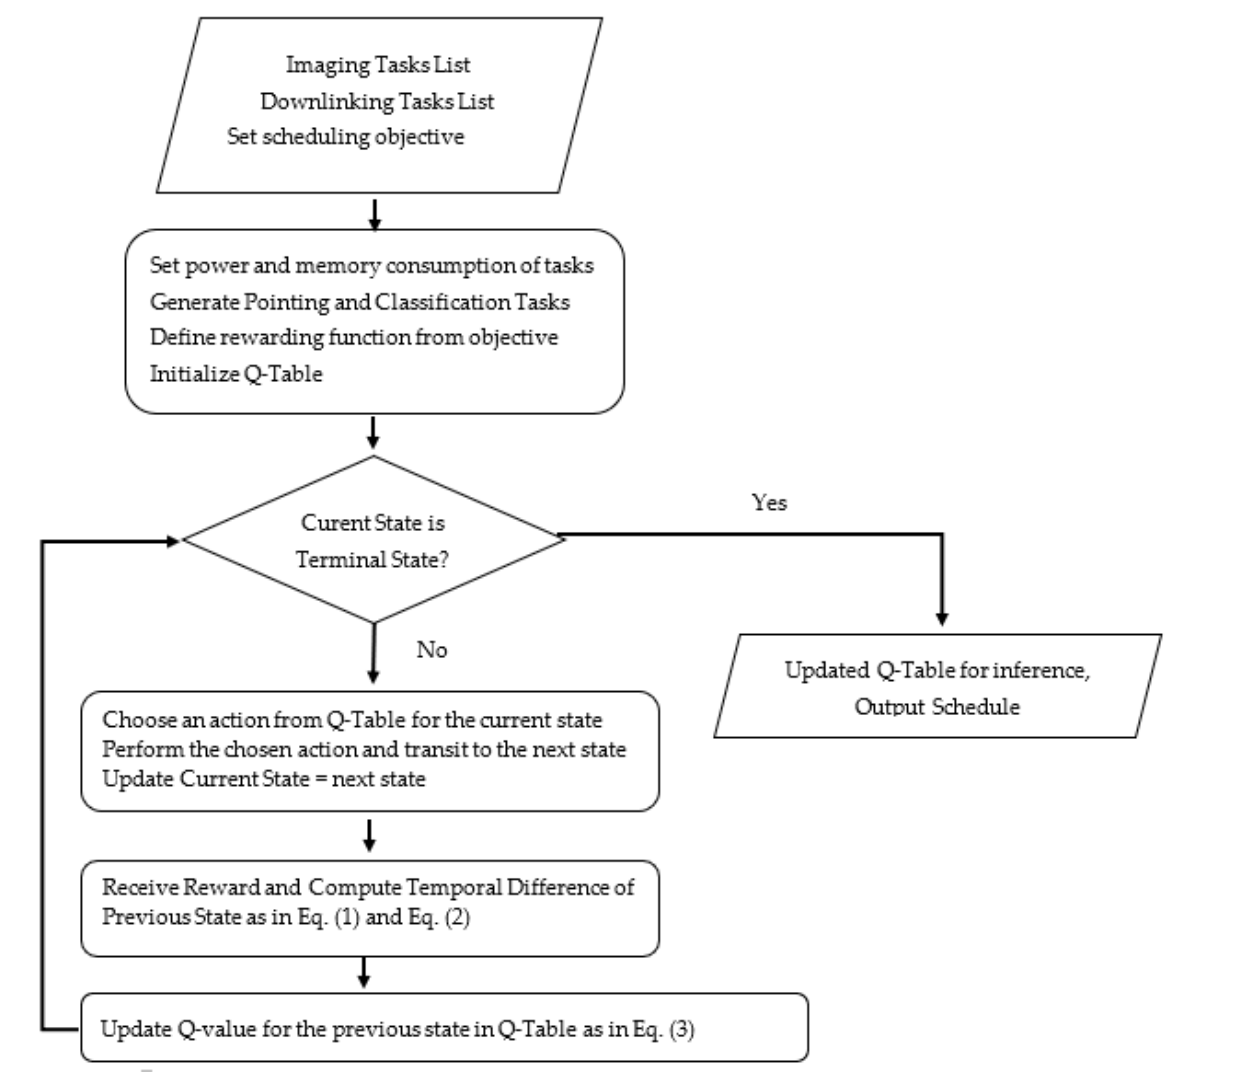
Figure 7. Q-Learning Based Scheduling Flow Chart.